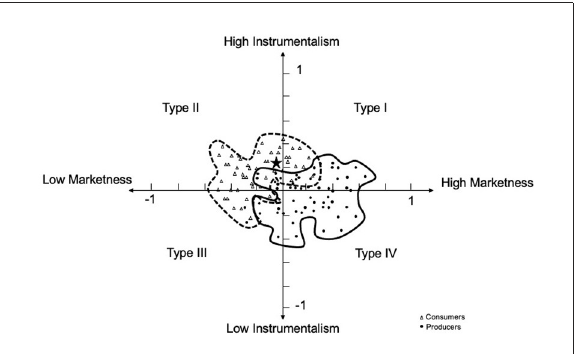
FIGURE4 Example embeddedness tool